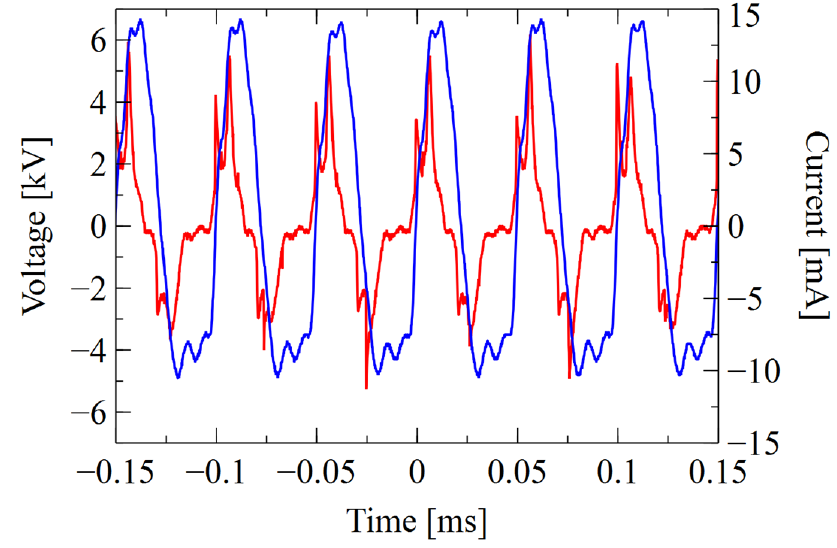
Figure 5. Waveform of voltage (blue line) and current (red line) for 1.5 L/min helium.